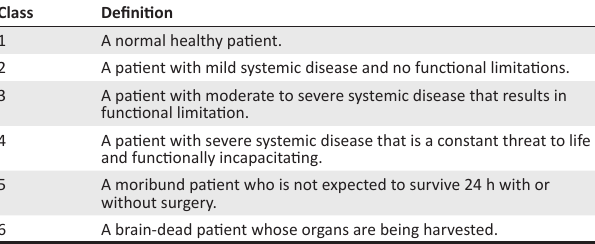
TABLE 2: Preoperative physical status classification according to the American Society of Anaesthesiology. Class